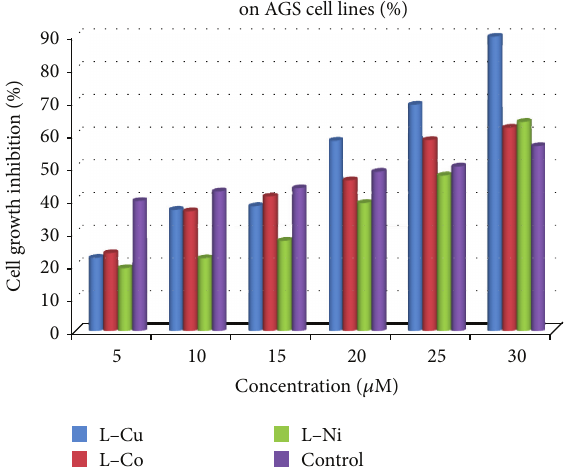
Figure 9: Treatment of complexes that exert an antiproliferative effect on liver cancer cell line. HepG2 cells were treated with complexes (Cu, Co, and Ni) for 48h. Control received appropriate carriers. Cell viability was assessed by MTT cell proliferation